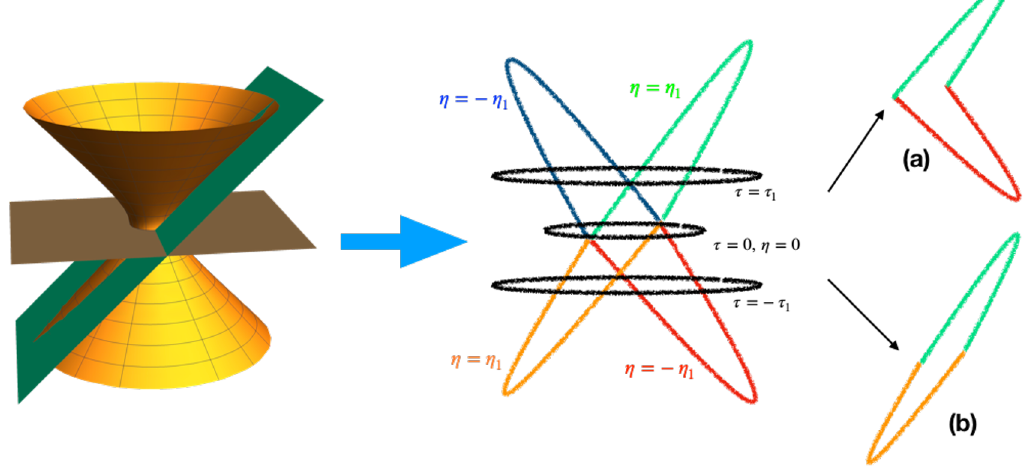
Figure 6 . An idealised illustration of constant timeslices in inertial and non-inertial case. Notice that the inertial τ and non-inertial η both coincide only at the initial slice and nowhere else. The three black sections correspond to inertial slices at 0 , ± τ 1 , while the green and orange (blue and red) segments make up the η 1 ( − η 1 ) non-inertial elliptical slices. Inset we show ways to recombine the segments into ‘closed’